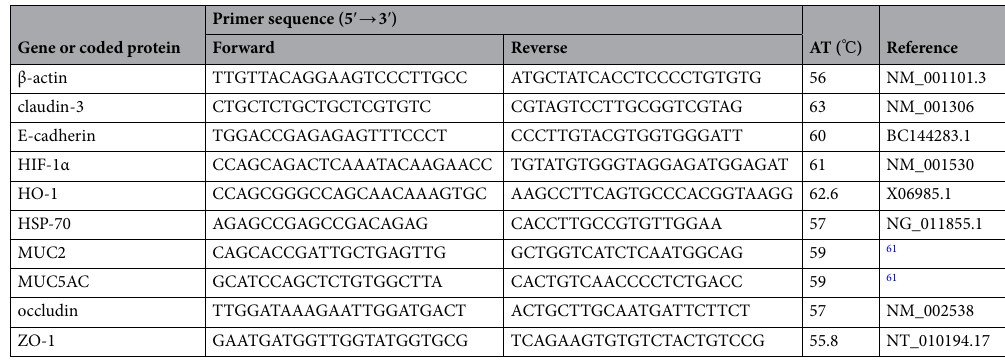
Table 1. Sequences of the used primers. AT: annealing